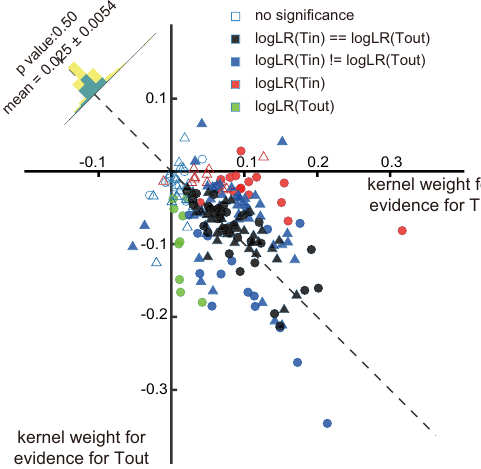
Fig.6|LIPneuronsencodedboth SW in and SW out .a Populationaveragedkernels for SW in (blue) and SW out (orange) for monkey H (upper panel) and monkey M (lower panel). The curve width denotes S.E. across units. The grey vertical lines indicate the onset of the next stimulus. b The neurons ’ selectivities for SW in and SW out , quanti fi ed as the average kernel weights within the time window, indicated bytheblacklinesonthe x axisin( a ).Eachmarkerisaneuron,whosecolorindicates thesigni fi canceoftheneuron ’ s SW in and SW out selectivity,andtheshapesindicate themonkeys(circles:monkeyM,triangles:monkeyH).Emptymarkers(monkeyM: 9,monkeyH:9)indicatetheneuronswithoutanysigni fi cantselectivity.Filledblack markers (monkey M: 41, monkey H:35) indicate the neurons that are selective to